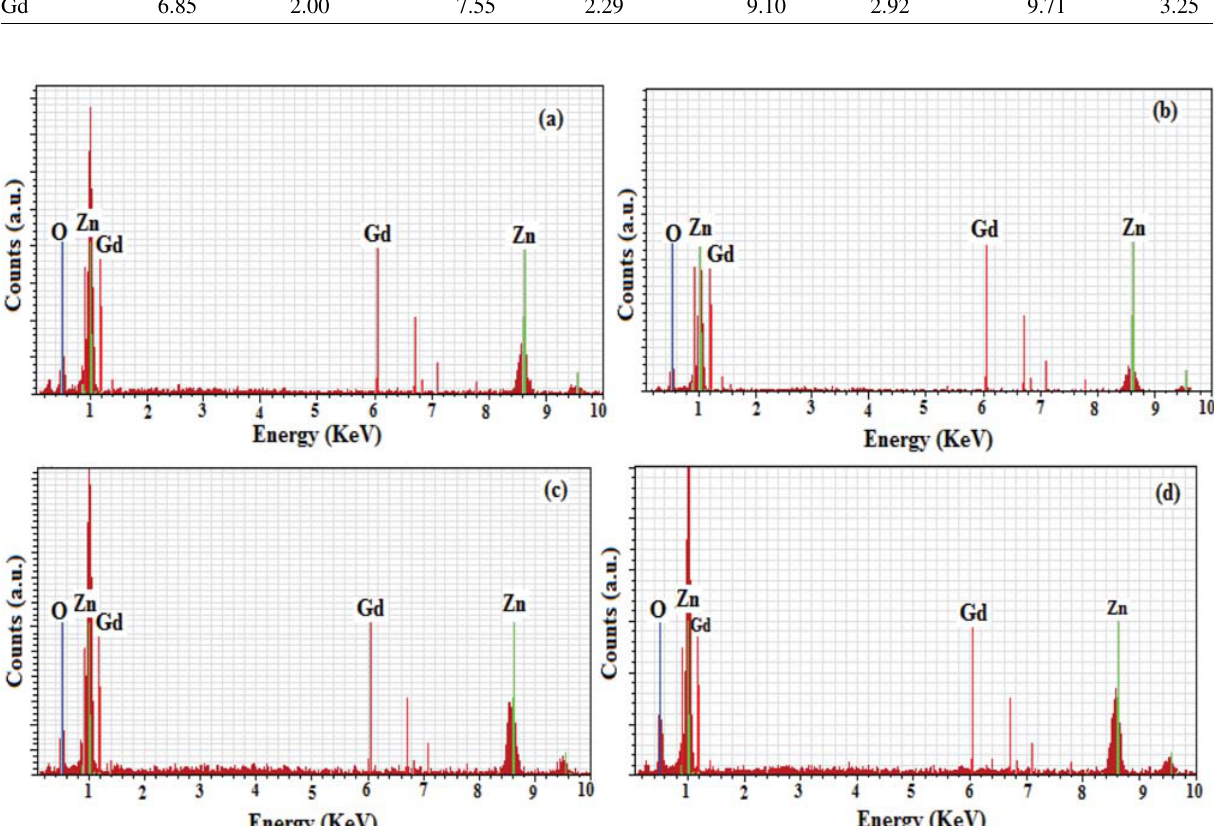
Figure 5. EDS spectra of (a) 1.0 mol% Gd doped ZnO (CTAB) (b) 1.5 mol% Gd doped ZnO (CTAB) (c) 1.0 mol% Gd doped ZnO (PVP) (d) 1.5 mol% Gd doped ZnO